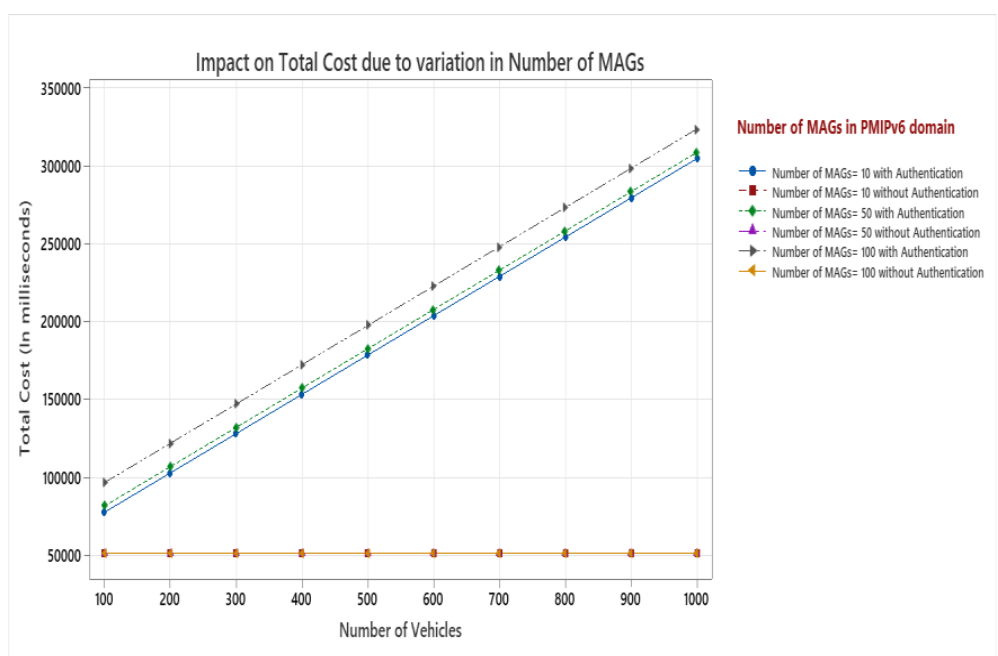
Figure 7. Impact on total cost with variation in number of MAGs.